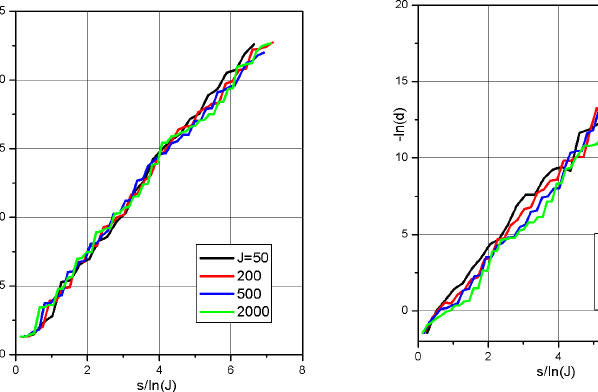
Figure 8. 5-solver, 9-scheme, Neumann, d-function.